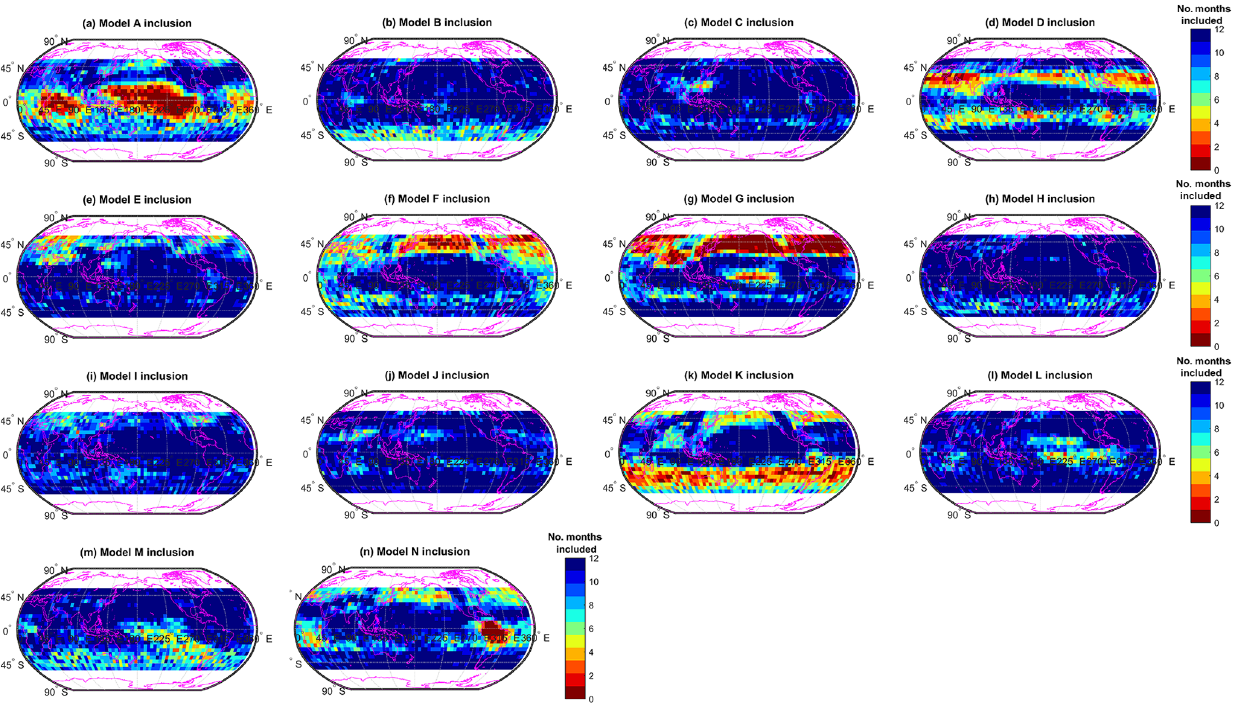
Figure 11. Number of months each model (names removed, labelled A–N) is included in the primary cluster. For a given region, models that are seldom included (i.e. a low numbers of months) differ more from the ensemble